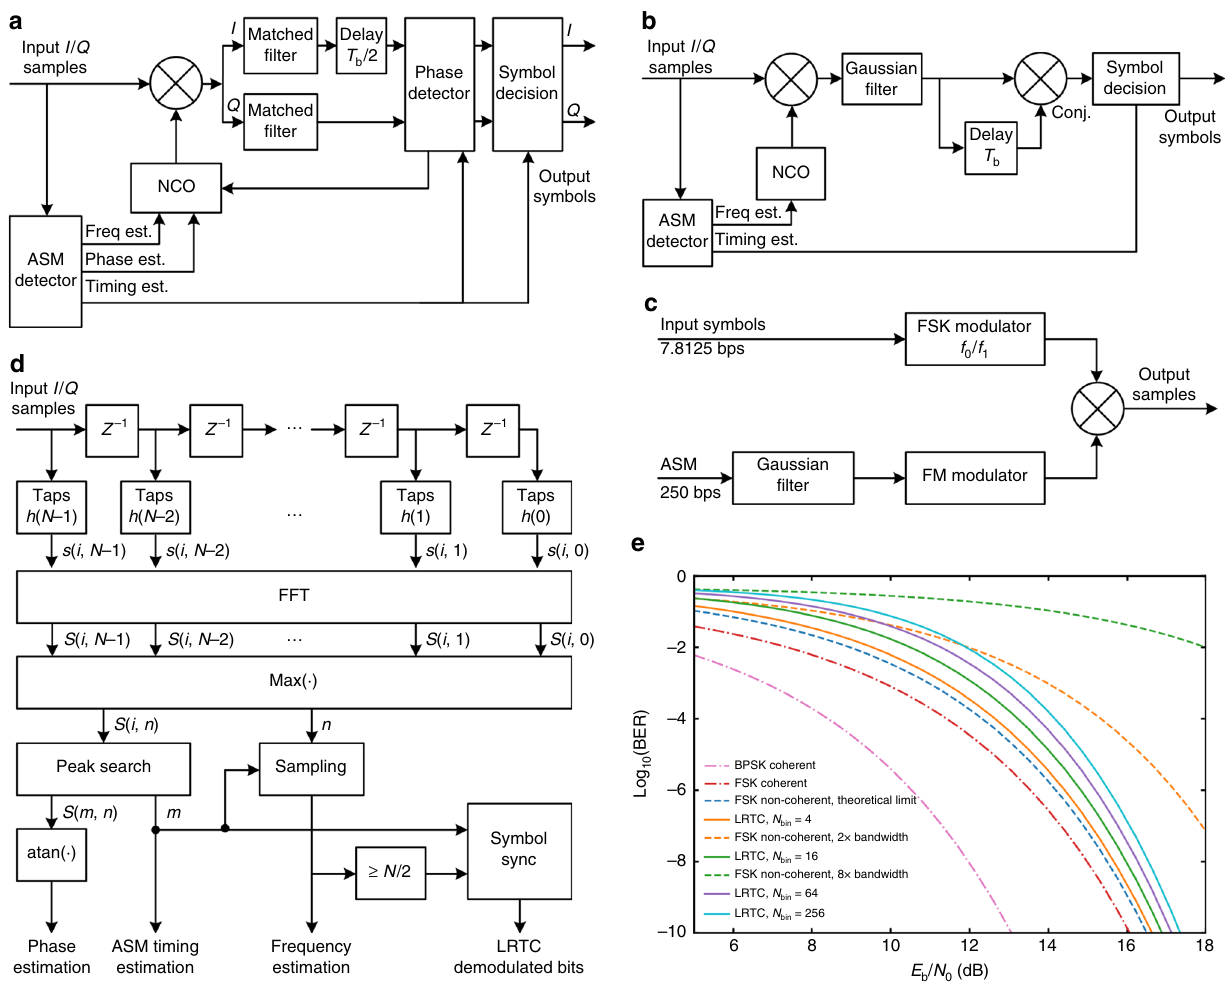
Fig. 3 Modulators and demodulators of the VHF/UHF communication system. a Block diagram of ground station GMSK coherent receiver. b Block diagram of onboard GMSK telecommand receiver. c Block diagram of ground station LRTC transmitter. d Block diagram of onboard LRTC receiver. e BER performance of LRTC demodulator compared with some other